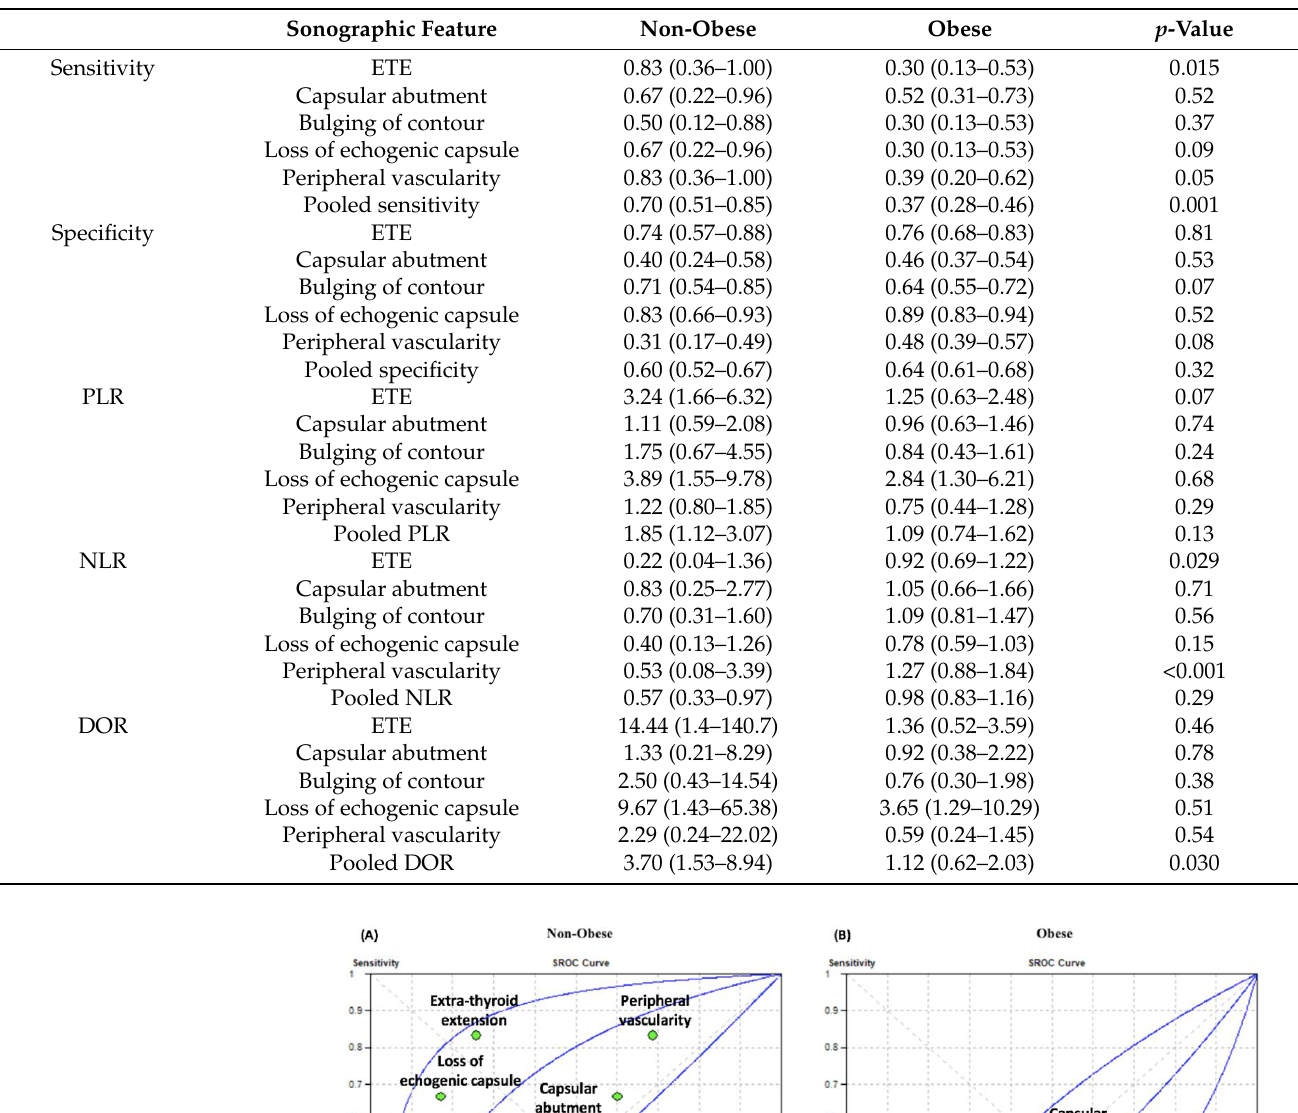
Table 2. Analysis of different sonographic features in assessing for extrathyroidal extension according to patient BMI. ETE: extrathyroidal extension. DOR: diagnostic odds ratio. PLR: positive likelihood ratio. NLR: negative likelihood ratio.